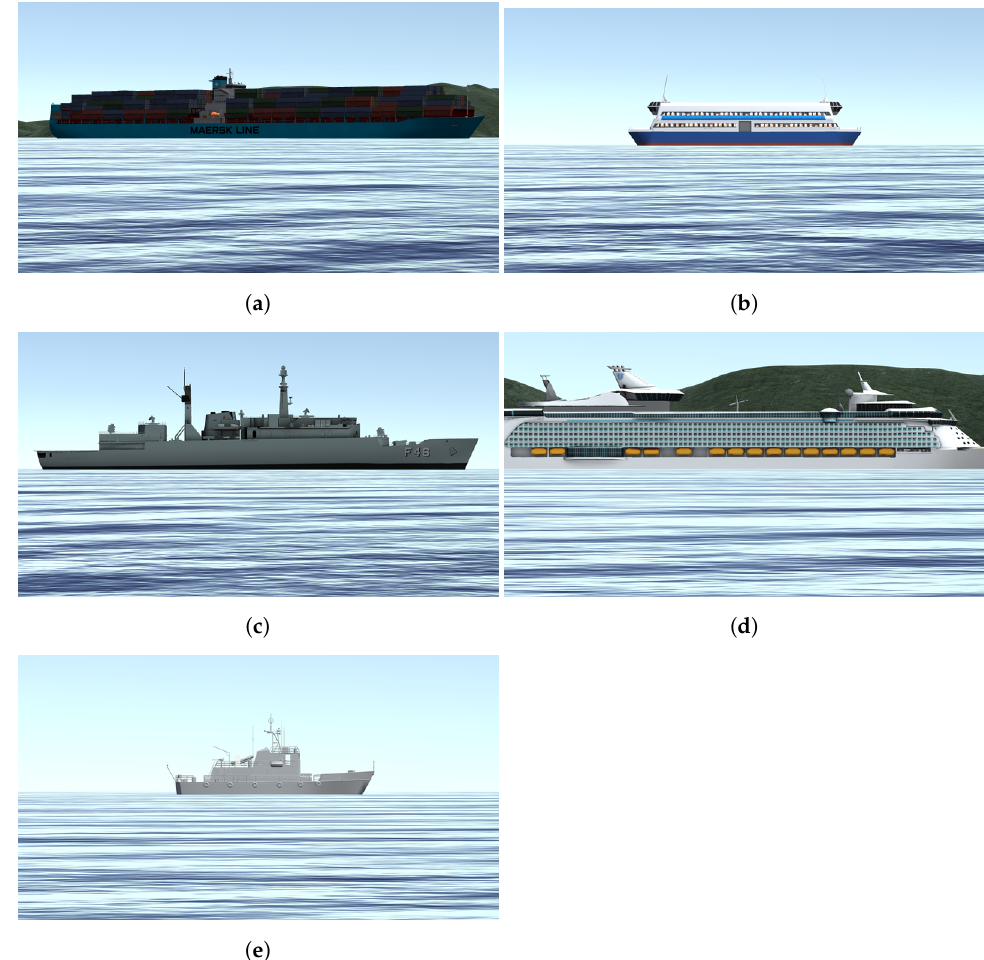
Figure 5. Classes of vessels considered while training the model using synthetic data; ( a ) Container